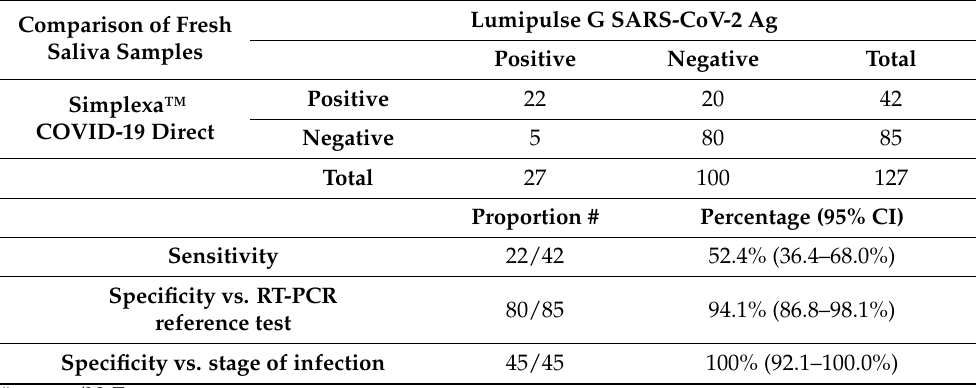
Table 5. Performance of Lumipulse G SARS-CoV-2 Ag vs. reference molecular test (Simplexa™ COVID-19 Direct) on fresh saliva